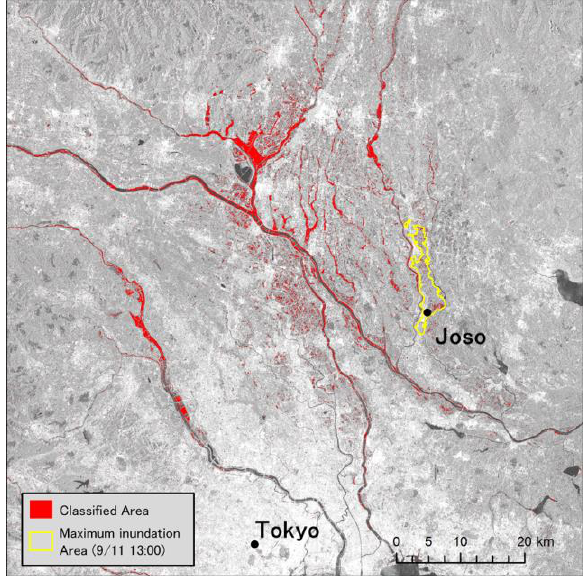
Figure 5. State of flooding in the upper reaches of the Tonegawa River by Sentinel-1 2015/9/10 5:40 JST